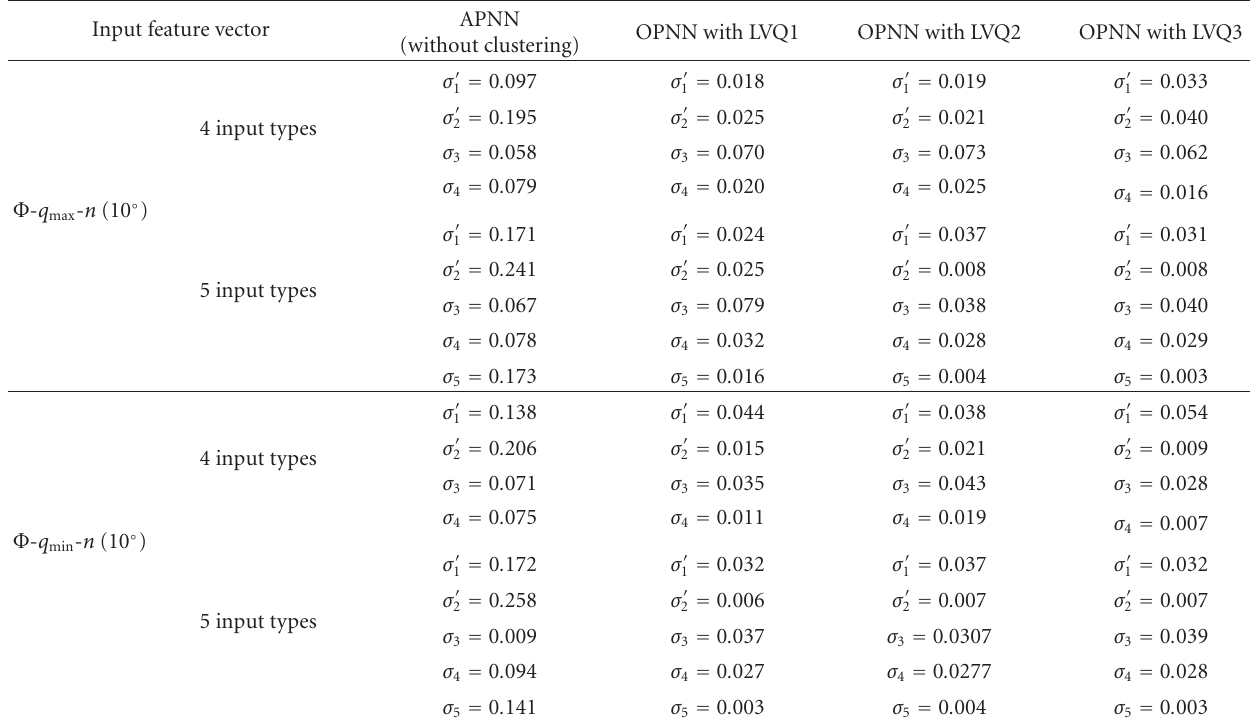
Table 5: Comparison on the role of variance parameter in classifying multiple PD sources.